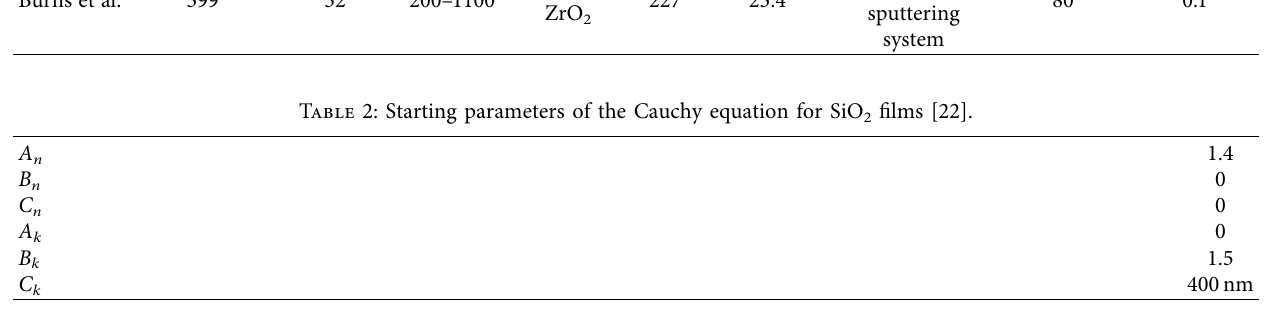
Table 3: Starting parameters of the Tauc–Lorentz oscillator for Nb